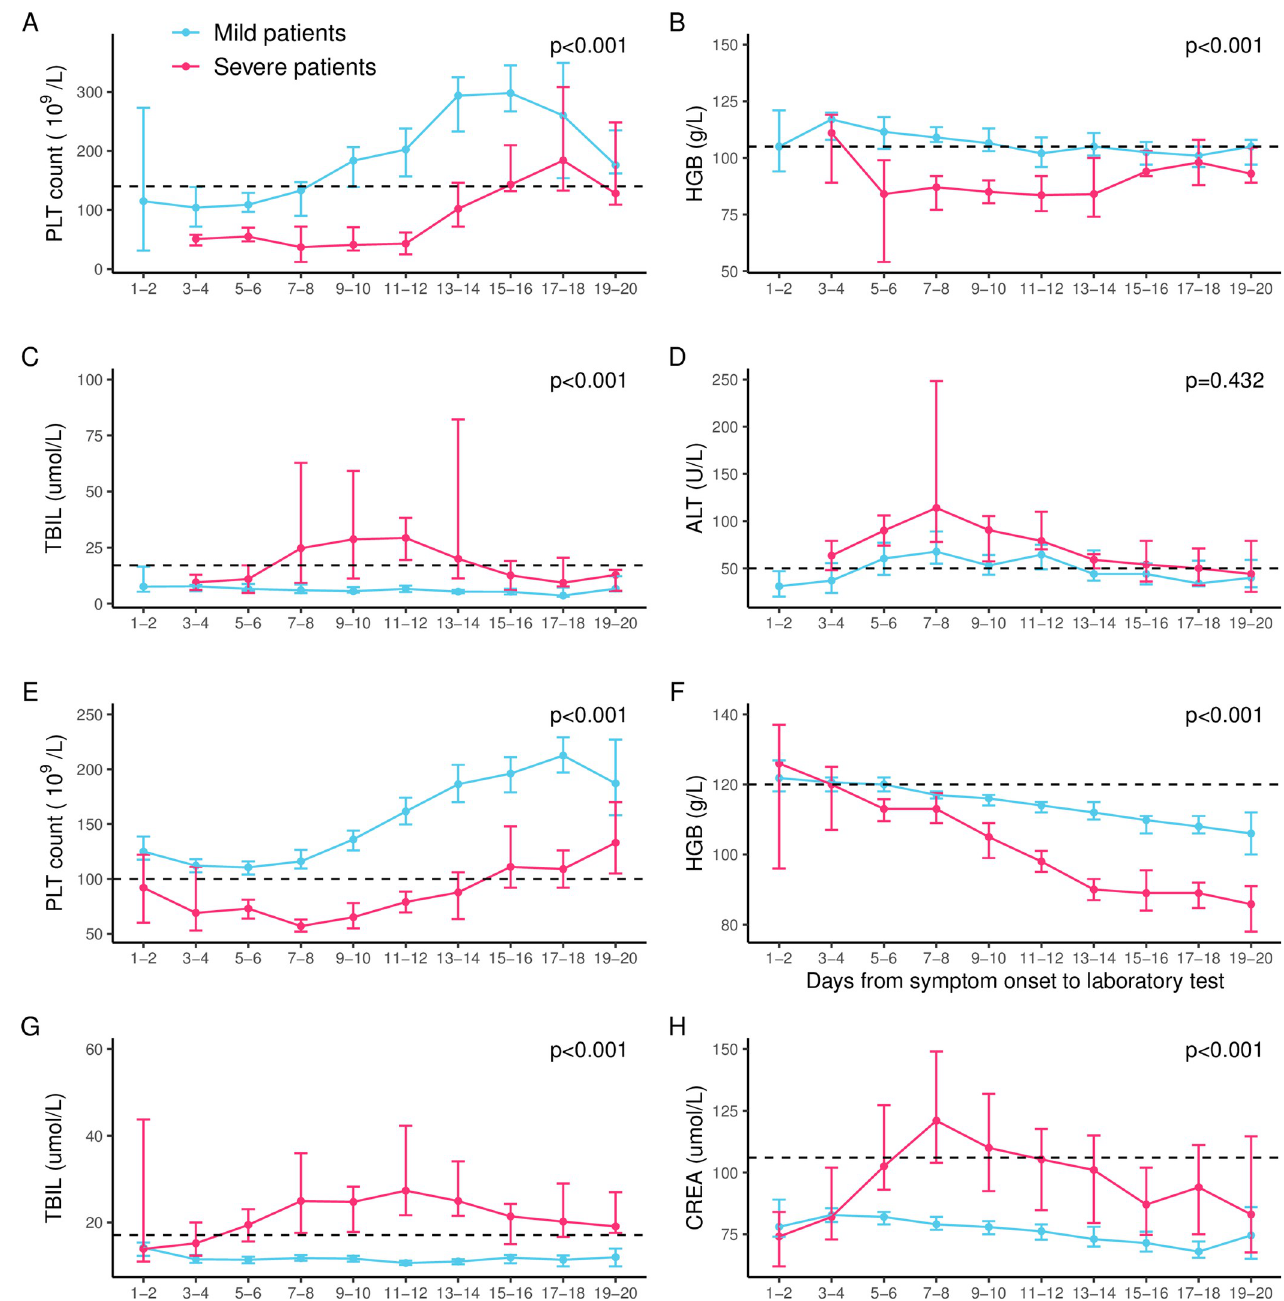
Fig 3. The dynamic pattern of major laboratory indicators associated with severe disease was delineated along the days from symptom onset by applying GEE for pediatric patients (A–D) and elderly patients (E–H). Four significant laboratory indicators in pediatric patients (age 0–14 years) were delineated: PLT count (A), HGB (B), TBIL(C), and ALT (D). Four significant laboratory indicators in elderly patients (age � 60 years) were delineated: PLT count (E), HGB (F), TBIL(G), and CREA (H). The median value was shown by point, and 95% confidence interval was shown in the error bars. Normal ranges for each variable are 140–440 × 10 9 /L for PLT count, 105–145 g/L for HGB, 5.1–17.1 umol/L for TBIL, and 0–50 U/L for ALT in pediatric patients, and 100–300 × 10 9 /L for PLT, 120–165 g/L for HGB, 5.1–17.1 umol/L for TBIL, and 53–106 umol/L for CREA in elderly patients. GEE, generalized estimating equation; PLT, platelet; HGB, hemoglobin; TBIL, total bilirubin; ALT, alanine aminotransferase; CREA, creatinine.